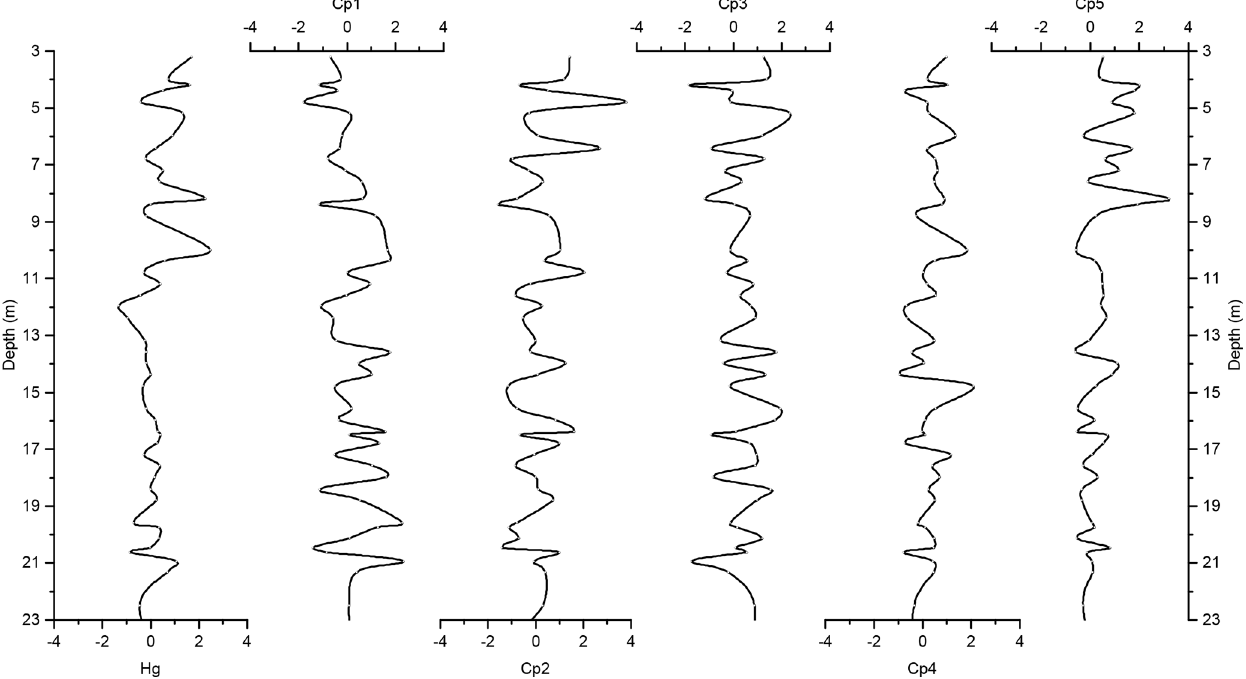
Figure 7. Depth records of scores of the principal components extracted by PCA on the elemental composition of the sediments along with Z score of Hg of the Adélie Basin sediments for the top 23m of the